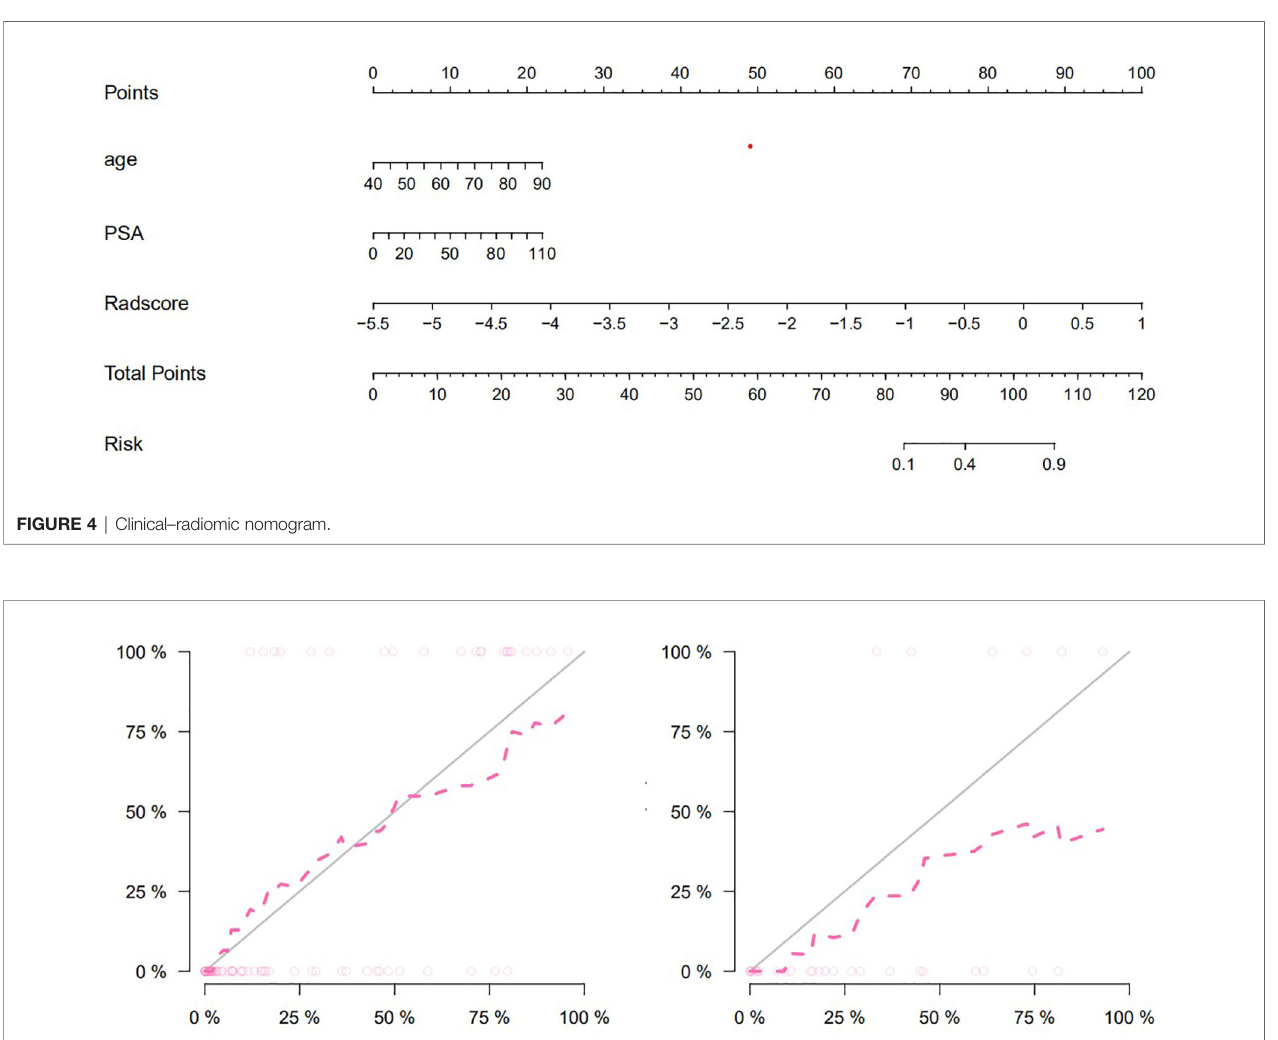
FIGURE 5 | Calibration curve for clinical – radiomic nomogram prediction of the consistency between the predicted results and pathological results (training set on the left, testing set on the right).